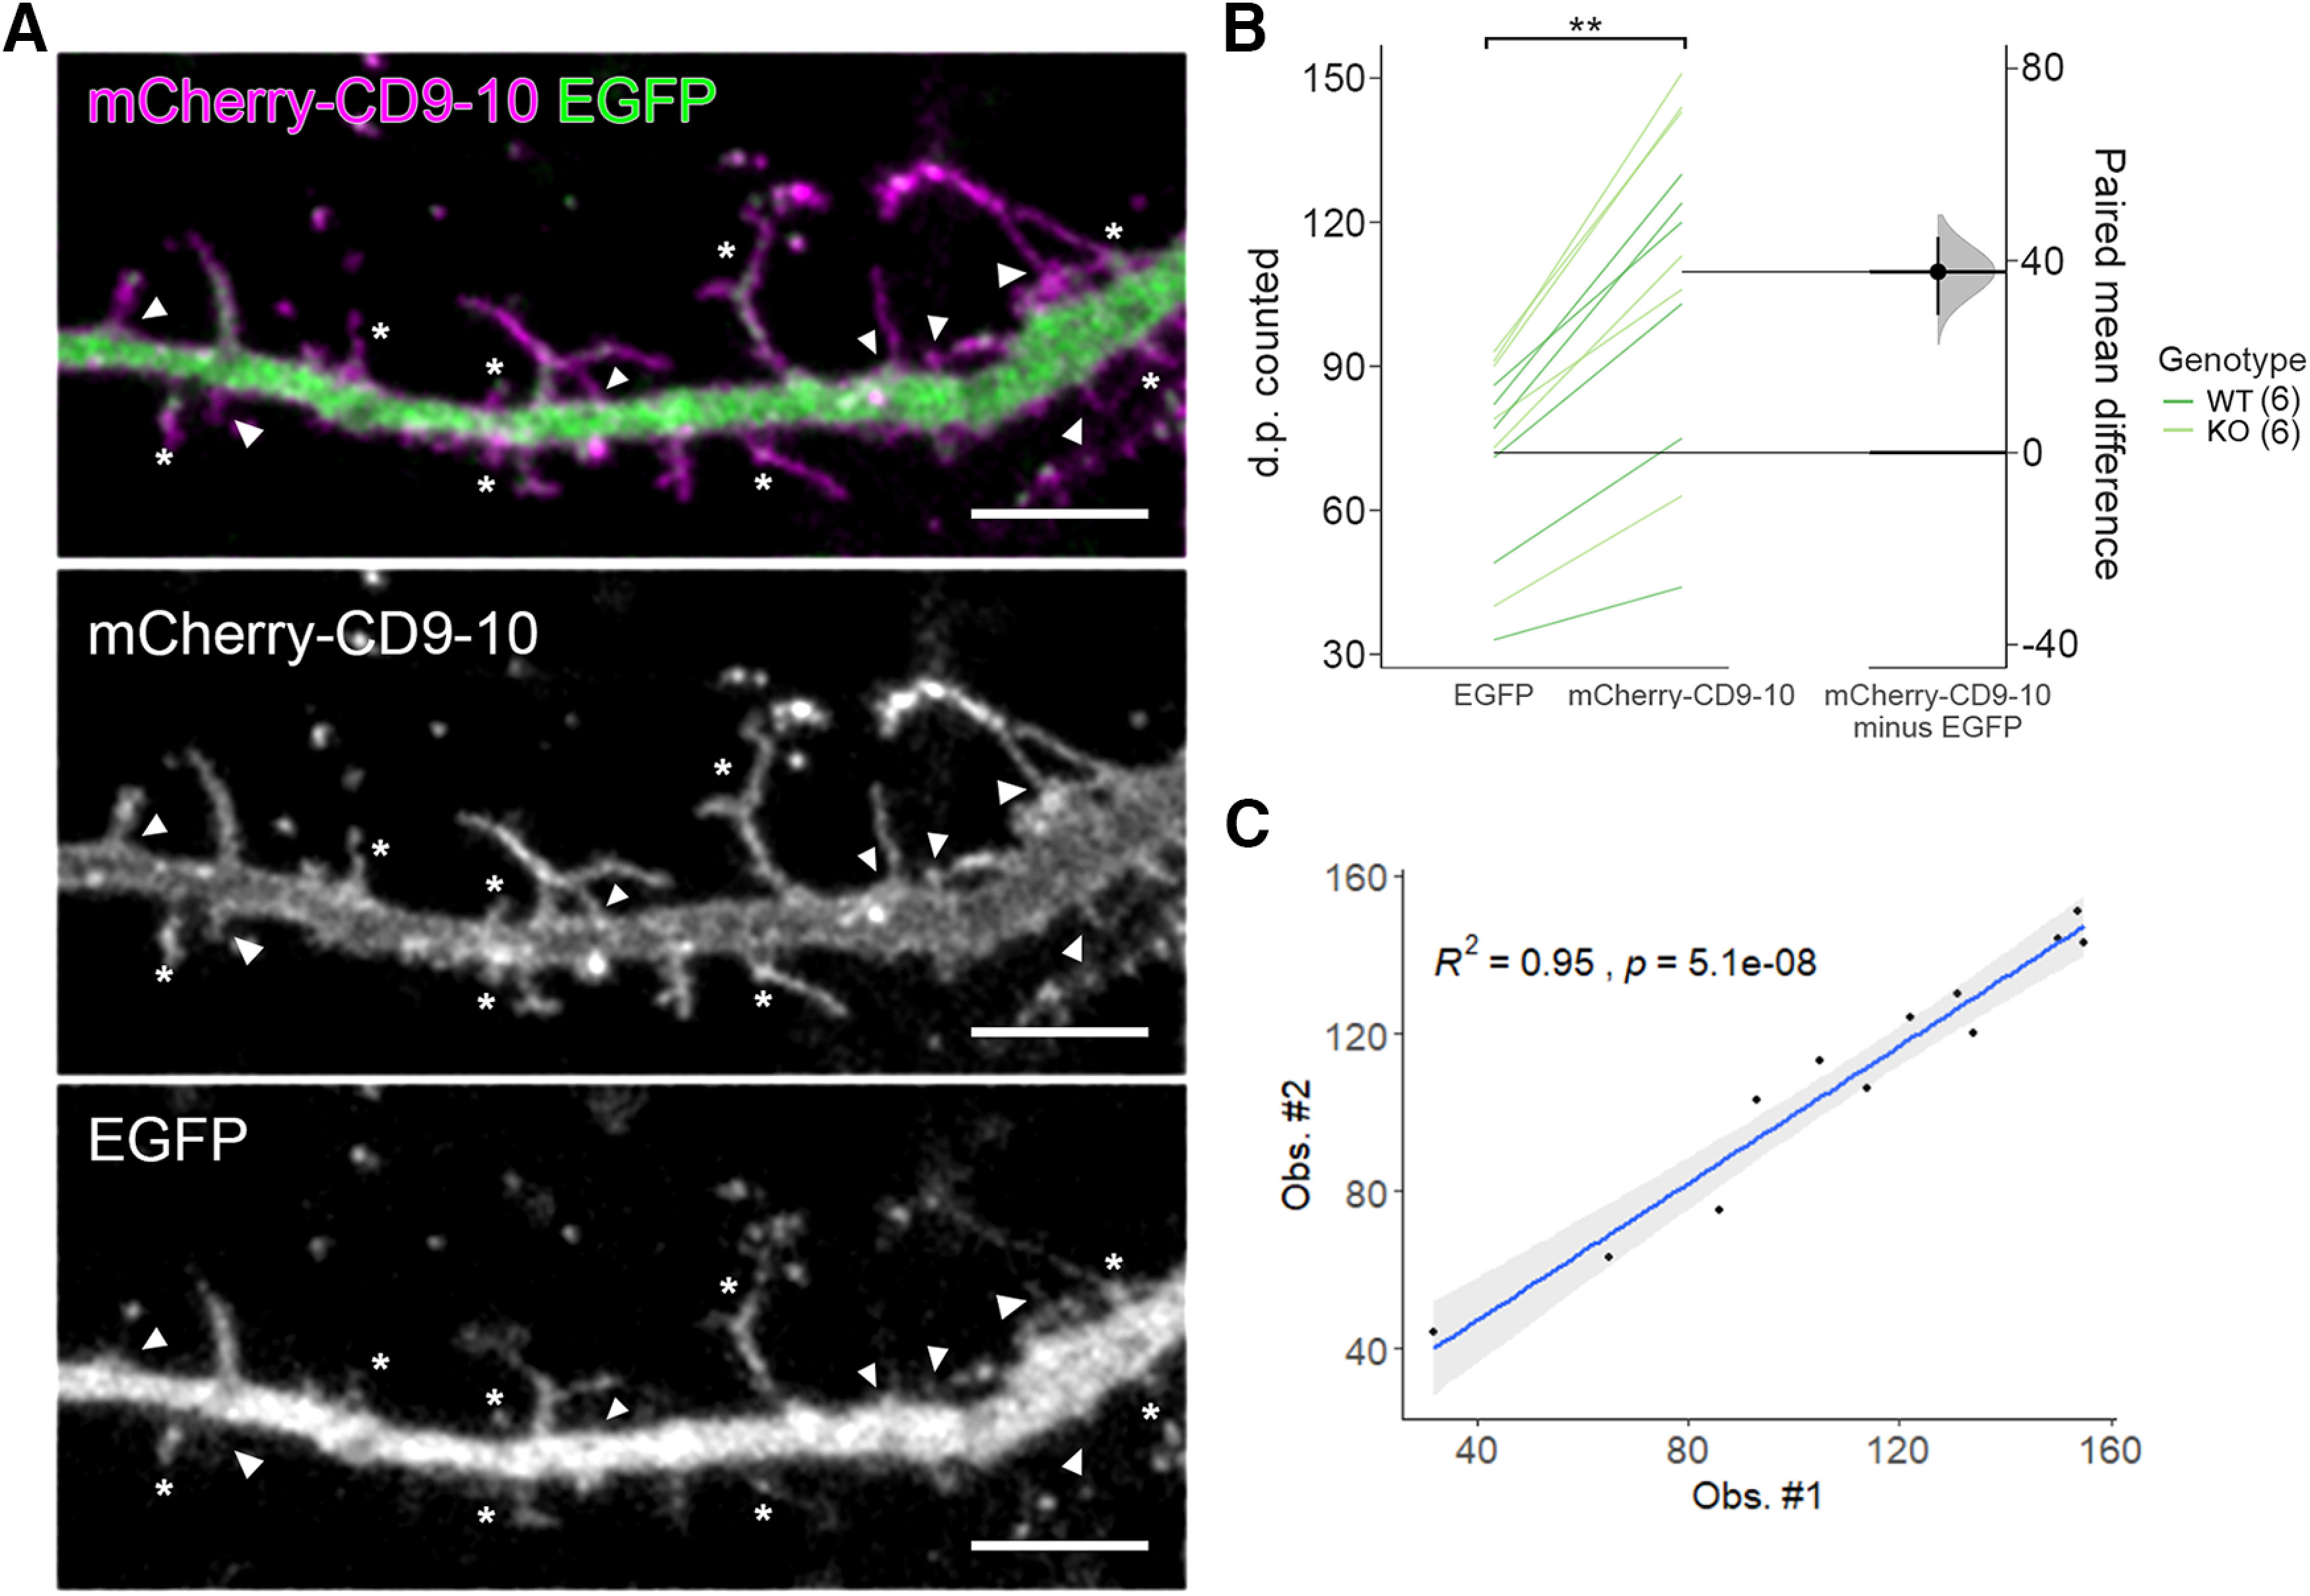
 Detection of dendritic protrusions in cortical neurons was improved with a membrane-bound fluorescent marker. A, Representative maximum intensity projection of a dendritic segment from a neuron transfected with mCherry-CD9-10 and EGFP at DIV6 and fixed at DIV10. Thin and long dendritic protrusions are more clearly visualized with mCherry-CD9-10 (mid) than the cytoplasmic volume marker EGFP (bottom). Structures not clearly labeled with EGFP are denoted by *, and those missed entirely are denoted with arrowheads. B, Slopegraph showing the quantification of dendritic protrusions detected using the mCherry-CD9-10 signal compared with the EGFP signal. On average, 34% of dendritic protrusions detected with mCherry-CD9-10 were missed in the EGFP channel (EGFP: 72 ± 5.9 dendritic protrusion; mCherry-CD9-10: 110 ± 9.7 dendritic protrusions; p = 0.00384, Student’s t test; N = 12 neurons, 6 WT and 6 Panx1 KOa1). C, The interobserver variability was evaluated with Pearson’s correlation and found to be R2 = 0.95 (95CI 0.84–0.98, p = 5.1e−08)a2. d.p., dendritic protrusion; **<0.01. Effect sizes are reported in Table 2. Scale bar: 5 µm. These data are included in the PhD thesis of J.C.S.-A, University of Victoria (Sanchez-Arias, 2020), found at http://hdl.handle.net/1828/11714.